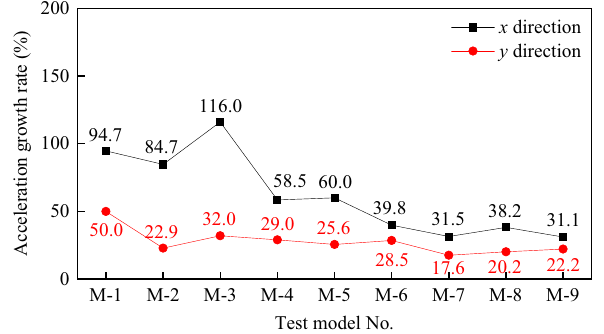
Test model No. Figure 14. Growth rate of acceleration at the top of each bridge pier with seismic